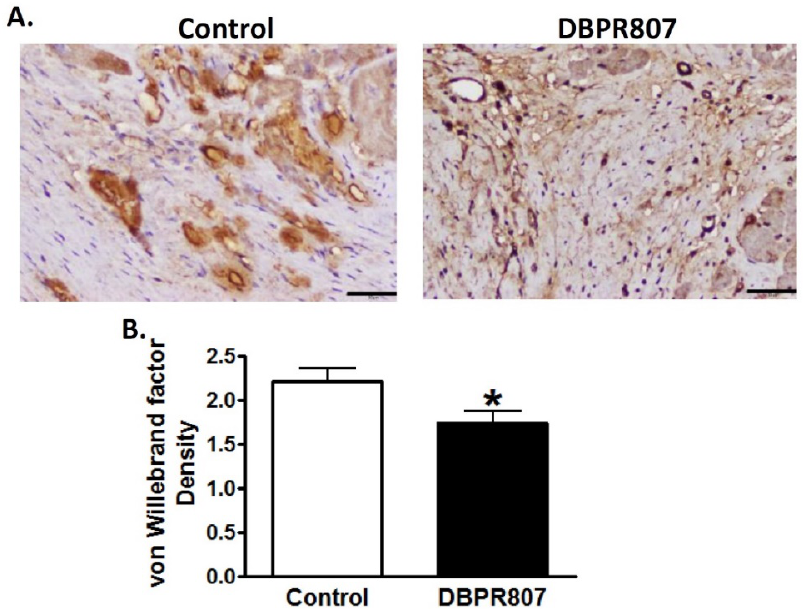
Figure 7. DBPR807 preserved integrity of capillaries after IR injury in the mini-pig model. Mini-pigs were treated with or without DBPR807 (3 mg/kg) after IR injury ( n = 10 per group). ( A ) vWF was stained 12 weeks after IR injury; scale bar = 50 μm on 200× field. ( B ) The density of vWF was quan- tified and presented as mean ± SEM. Statistical analysis was performed by t -test: * p < 0.05.